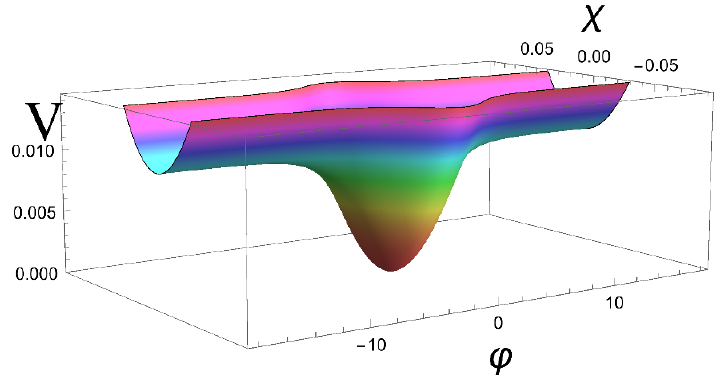
Figure 4 . In(cid:13)aton potential of the T-model version of the (cid:12)bre in(cid:13)ation potential for a particular p case M = m = 0 : 1, V 0 = 2